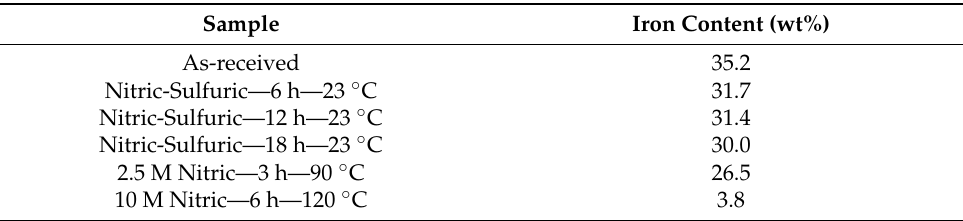
Table 4. Iron content for CNT samples: as-received, treated with nitric/sulfuric acid mixture at 23 ◦ C (6, 12, and 18 h), 2.5 M nitric acid at 90 ◦ C for 3 h, and 10 M nitric acid at 120 ◦ C for 6 h.